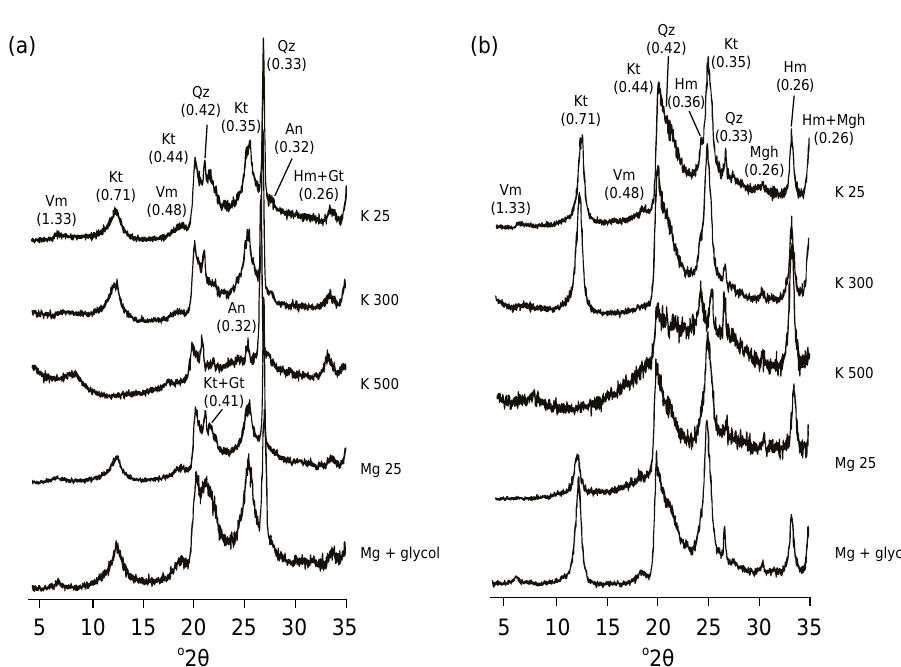
Figure 1. Clay fraction X-ray diffractograms of a Typic Rhodudalf without PS application (a) and of a Typic Hapludox without CPS application (b), from the 0.00-0.04 m layer. Slides with oriented samples saturated with K and air-dried (K 25); samples saturated with K and heated to 300 °C (K 300); samples saturated with K and heated to 500 °C (K 500); samples saturated with Mg and air-dried (Mg 25), and saturated with Mg and solvated with ethylene glycol (Mg + glycol). d spacing in nm. Vm = vermiculite; Kt = kaolinite; Gt = goethite; Qz = quartz; Hm = hematite; Mgh = maghemite; An = anatase.